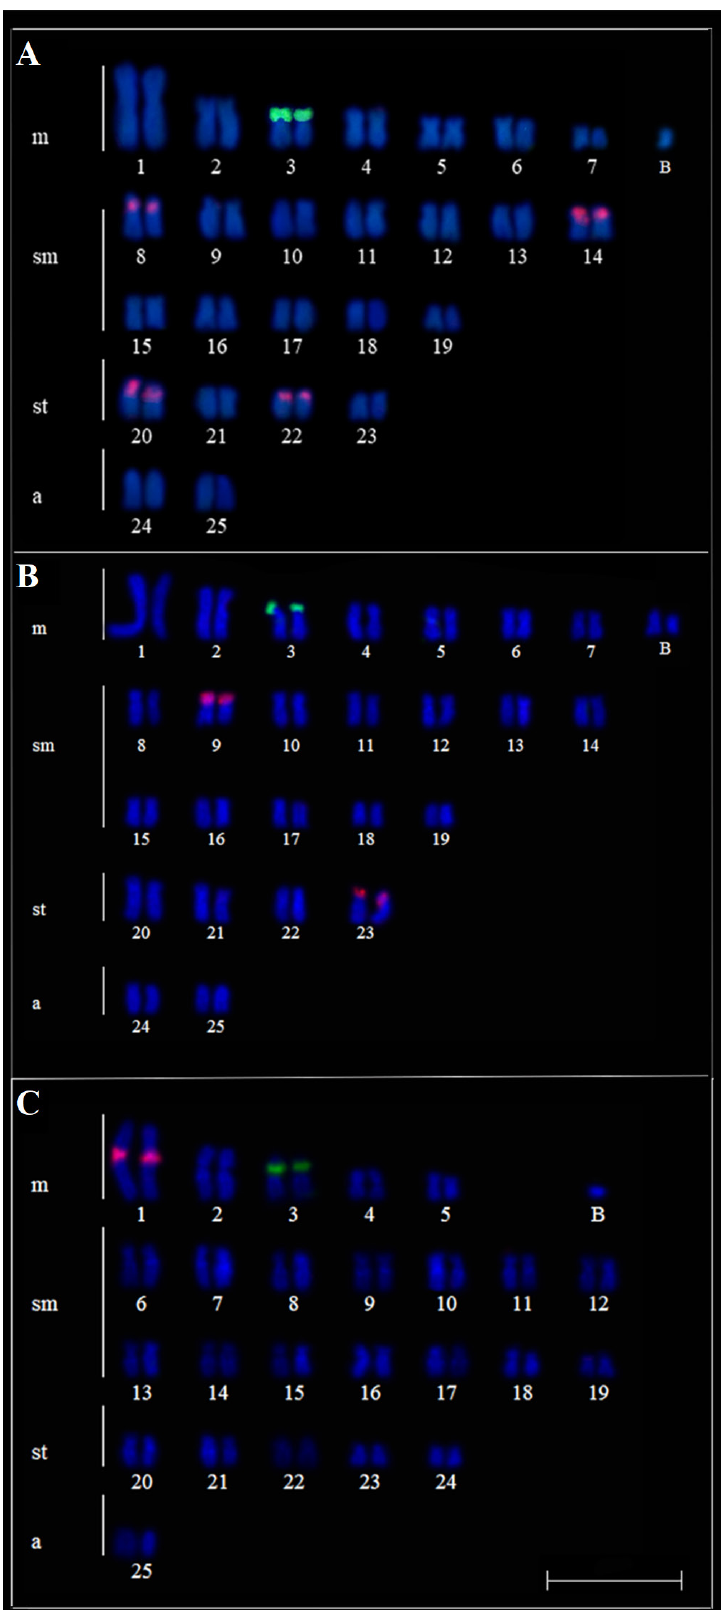
FIGURE 2 | Karyotypes A. Moenkhausia bonita from the Índios River, B. M. bonita from the Paraná River, and C. M. forestii from the Paraná River after double- FISH with 18S rDNA (green) and 5S rDNA (red) probes. In evidence B chromosomes ( B , C ). Scales bar = 10